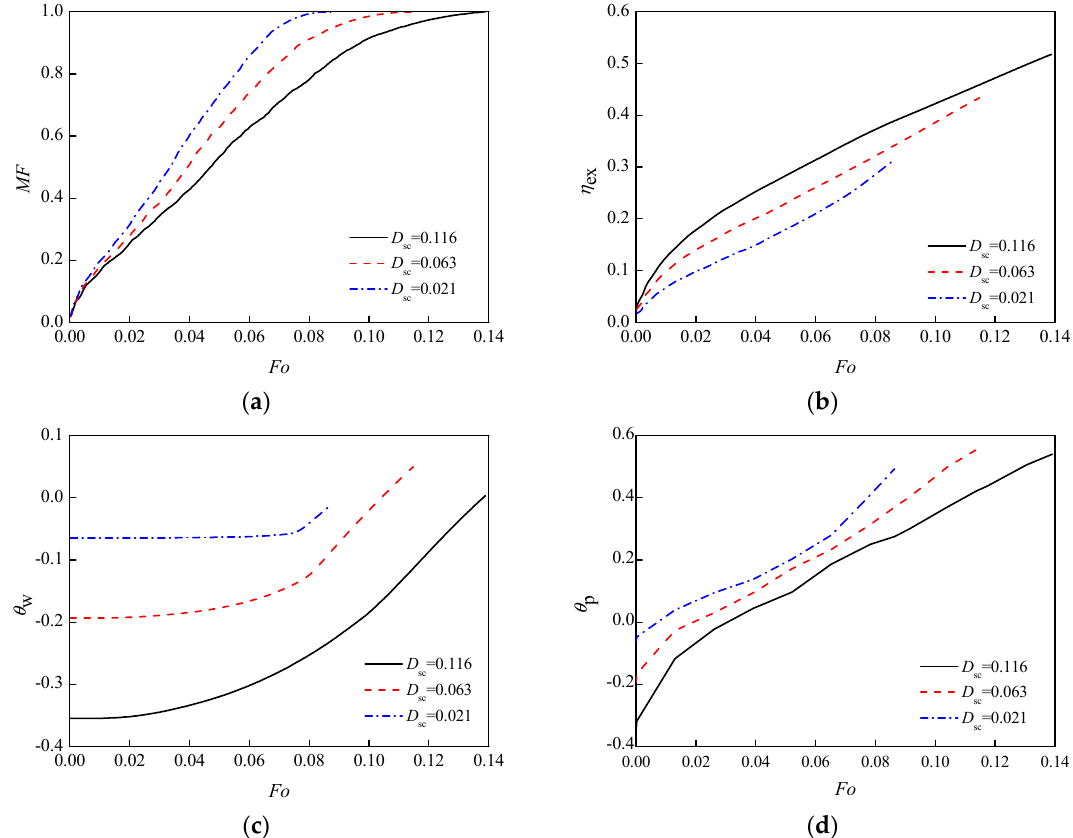
Figure 9. Evolution of the performance parameters for varying degrees of sub-cooling: ( a ) melting fraction; ( b ) exergy efficiency; ( c ) water temperature; ( d ) paraffin temperature.